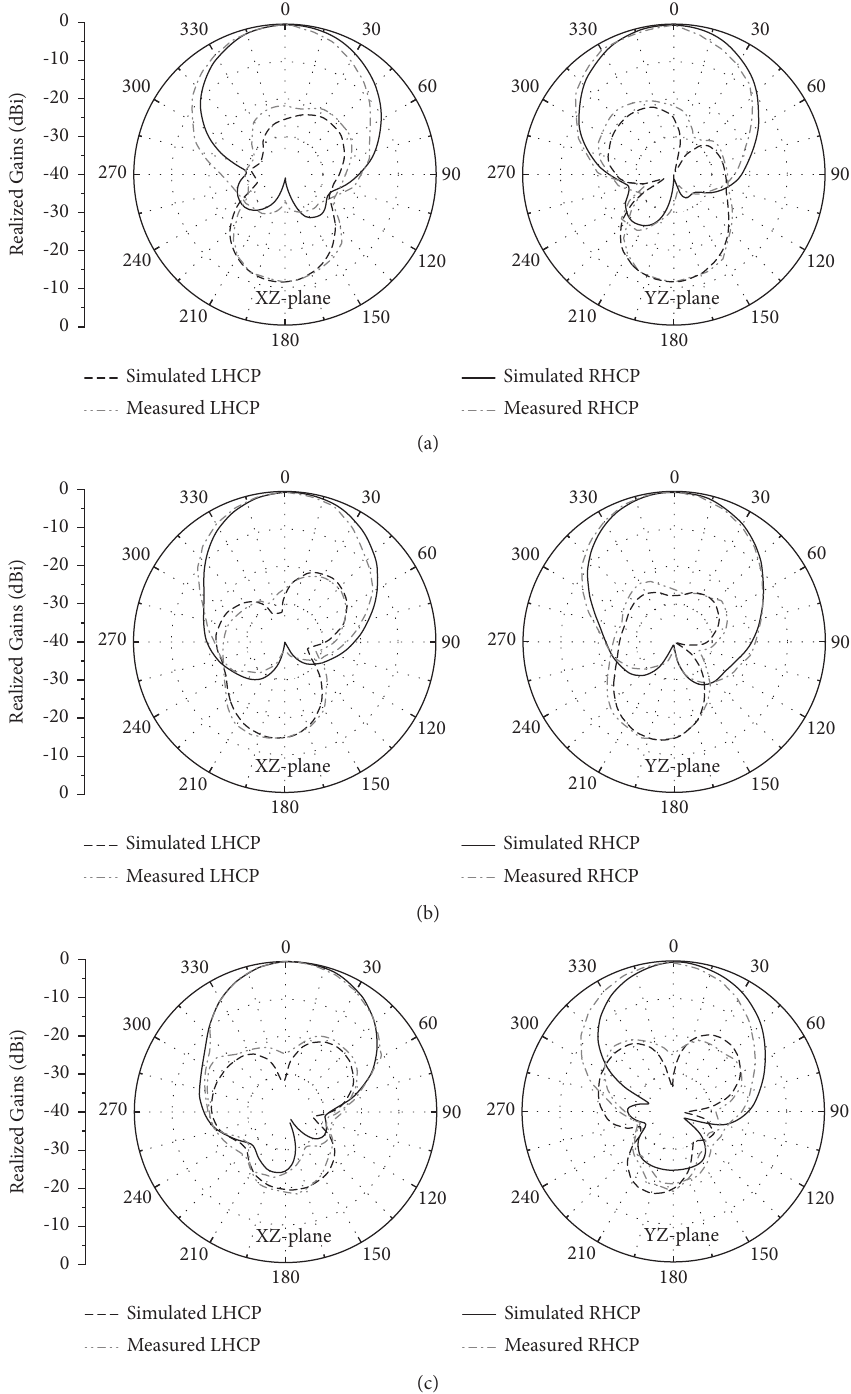
Figure 5: Simulated and tested radiation patterns of the designed antenna at (a) 4.7GHz, (b) 5.0 GHz, and (c)